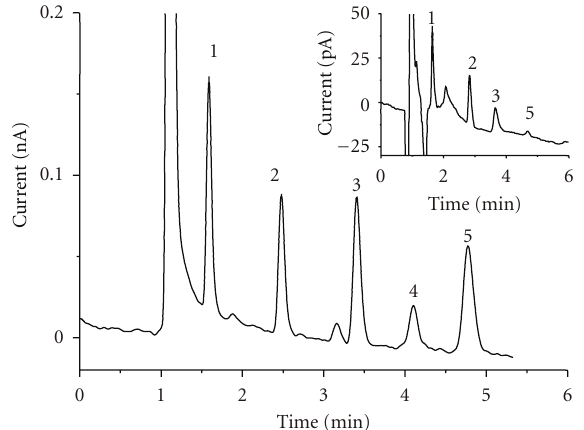
Figure 5: Chromatogram of standard mixture of phenolic acids. Conditions: amperometric detection at 1200 mV (versus Ag/AgCl), for other conditions see Section 2; analyte concentration: 10ng/mL each. Inset chromatogram: analysis of 1ng/mL concentration (2.5pg on-column each acid). Legend: 1: gallic acid, 2: protocate- chuic acid, 3: gentisic acid, 4: p -hydroxybenzoic acid, and 5: ca ff eic